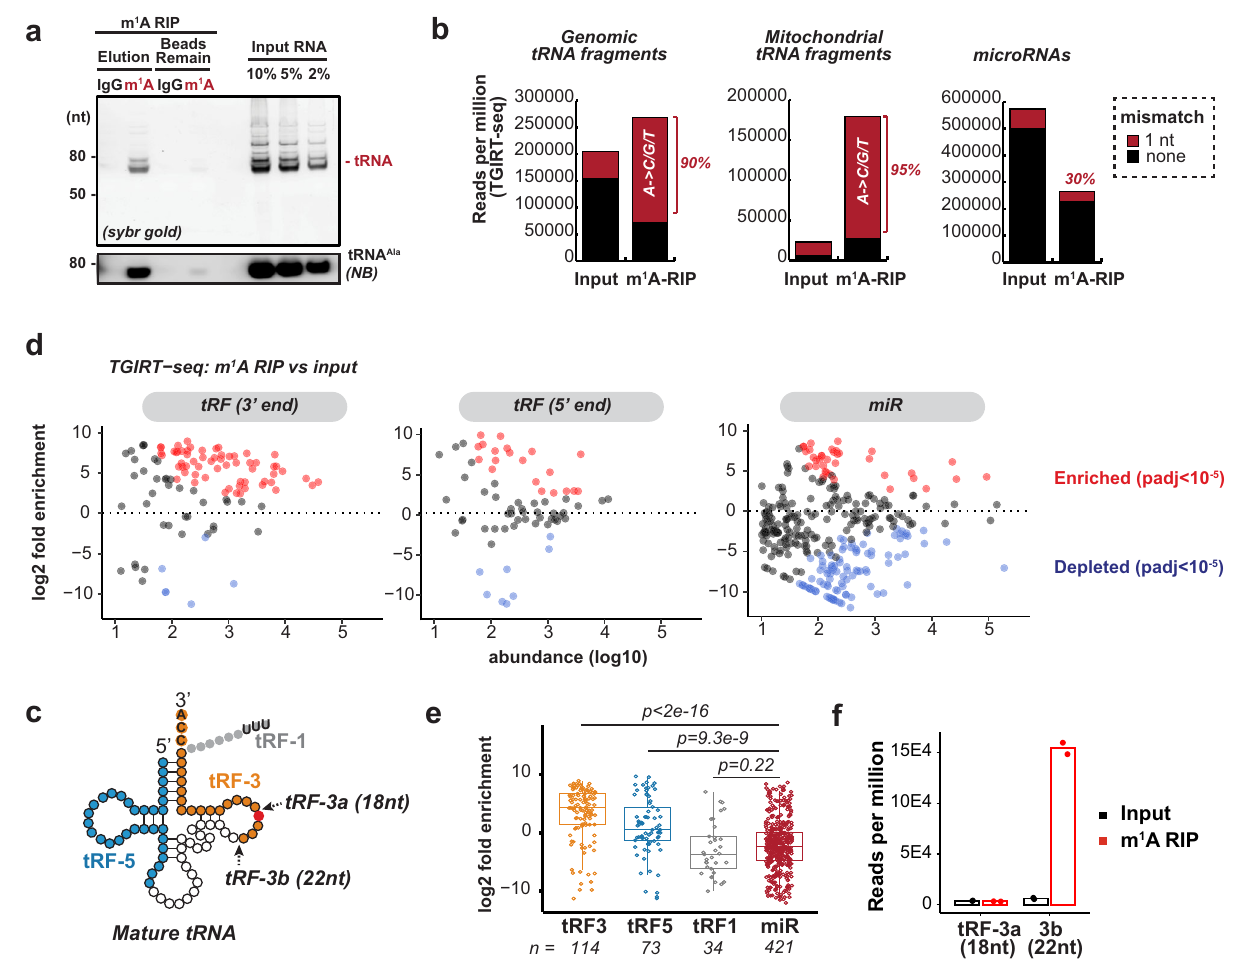
Fig. 2 Speci fi c tRNA-derived fragments are highly enriched for m 1 A. a m 1 A RNA immunoprecipitation (RIP) successfully enriches for tRNAs compared to IgG control RIP, by both Sybr gold staining and Northern blot against tRNA Ala . b m 1 A RIP enriches for reads that contain A->C/G/T mismatch in tRNA fragments. Bar graph represents RPM (reads per million) values for each group of small RNAs allowing no mismatch (black) and additional mapped reads when allowing 1-nt mismatch (red). Labeled percentage shows the percentage of A->C/G/T mismatch among all mismatches. c Major types of tRFs include tRF-3s (3 ′ end of mature tRNAs), tRF-5s (5 ′ end of mature tRNAs) and tRF-1s (trailer of precursor tRNAs). tRF-3s have two major isoforms, tRF-3b (22-nt) and tRF-3a (18-nt). d , e tRF-3s are signi fi cantly enriched by m 1 A RIP. d Log2 fold enrichment (m 1 A RIP/input) was plotted against small RNA abundance for different RNA groups. Only signi fi cantly (p.adj < 10 − 5 by DESeq2 Wald test with multiple hypothesis adjustment) enriched or depleted RNAs were colored. e tRF-3s ( n = 114) and tRF-5s ( n = 73), but not tRF-1s ( n = 34) are signi fi cantly more enriched by m 1 A RIP than miRs ( n = 421) ( p value by two-sided Wilcoxon test compared to miRs). Boxplot center represents median, bounds represent 25 and 75%, and whiskers show the minimum or maximum no further than 1.5 * interquartile range from the bound. f Bar graph shows 22-nt tRF-3b but not 18-nt tRF-3a are signi fi cantly enriched by m 1 A RIP compared to input. Data in this fi gure are based on TGIRT-seq of two independent RIP experiments in HEK293T. See also Supplementary Fig. 2. Source data are provided as a Source Data fi